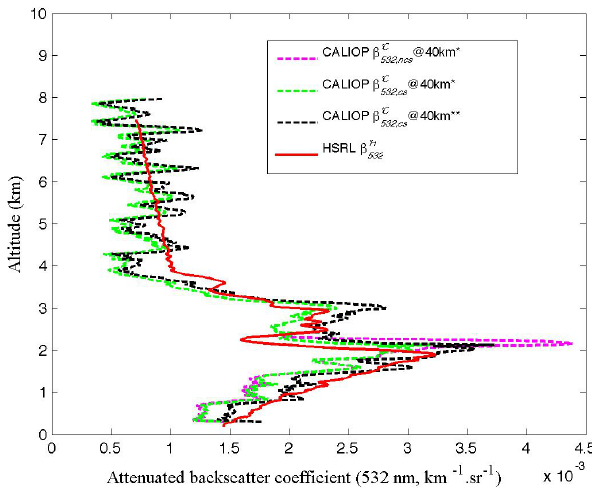
0 H (red), alternative 532